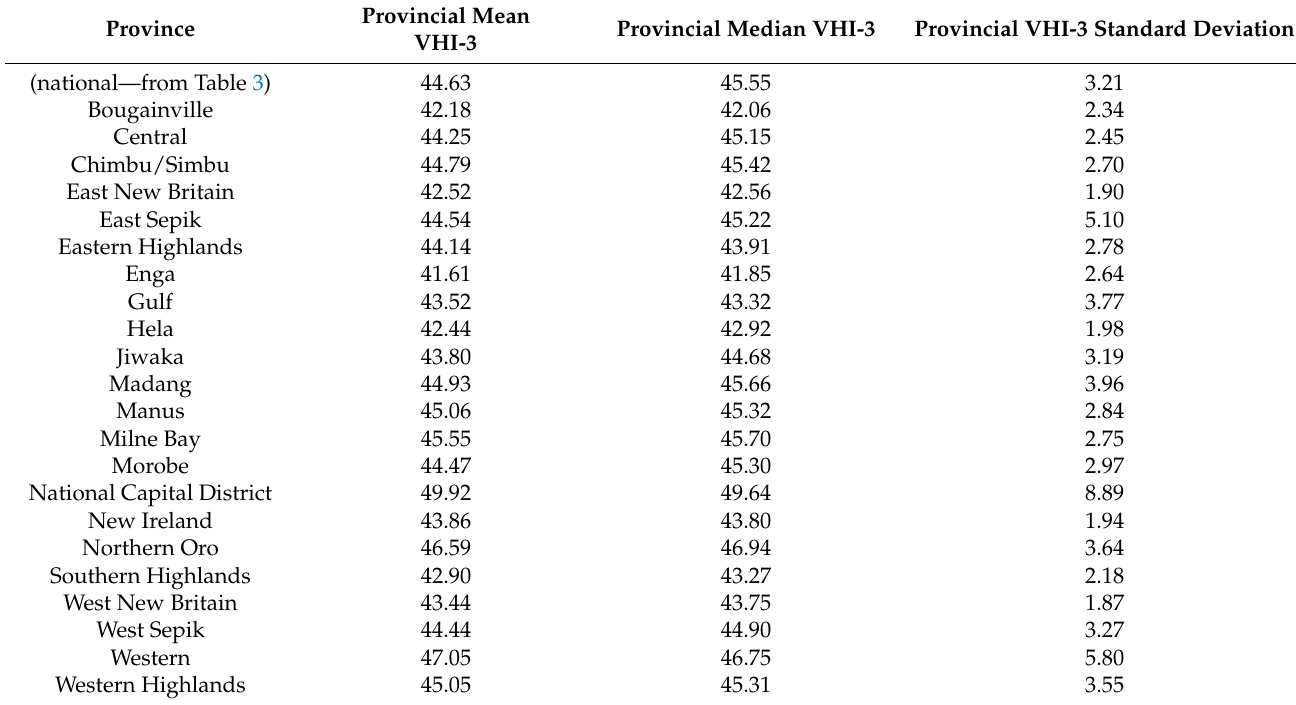
Table A2. Mean, median and standard deviation for provincially averaged